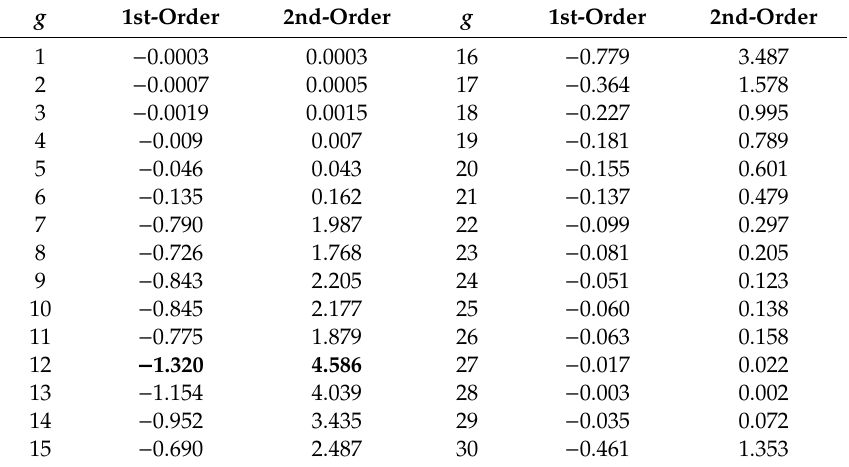
(cid:16) (cid:17)(cid:16) (cid:17) ∂ L / ∂σ g σ g / L , g = 1, ... ,30 t , i = 2 t , i = 2